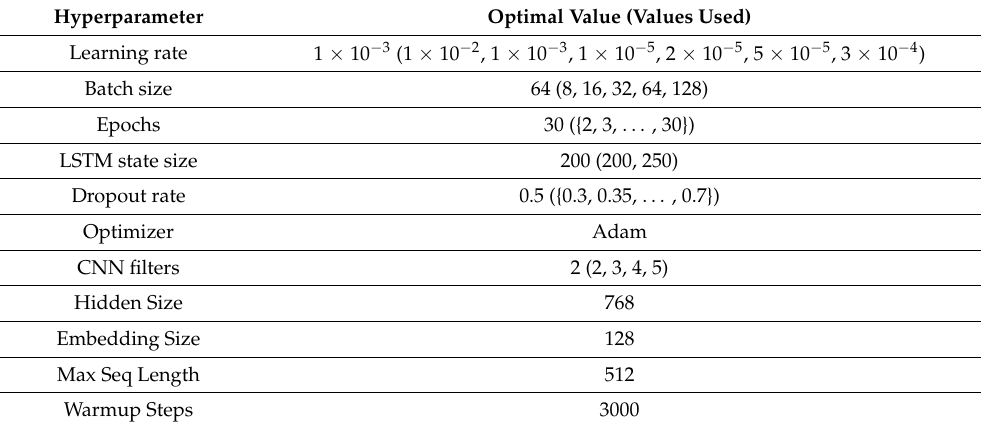
Table 3. Hyperparameters used—optimal parameter (range of values).